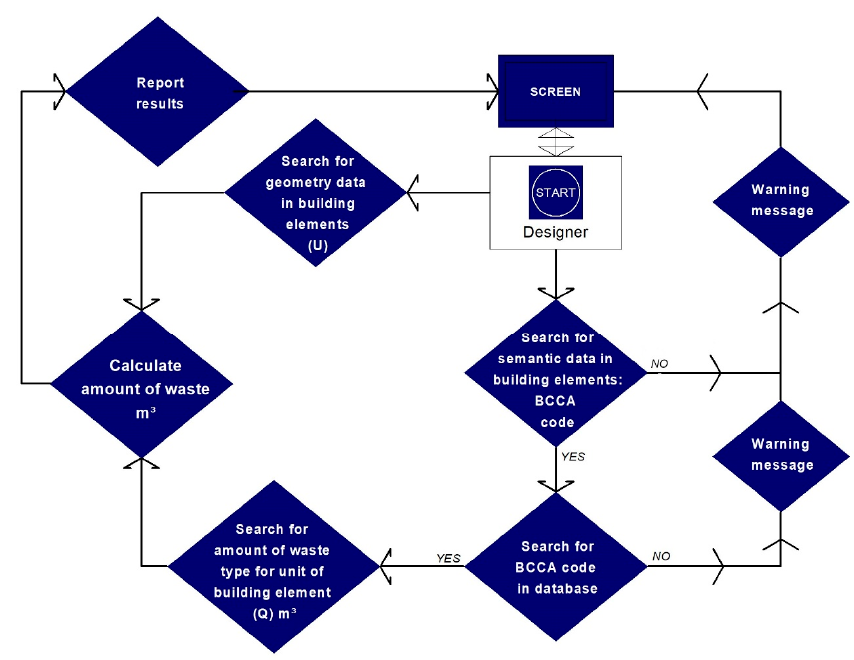
Figure 2. WE-BIM Add-in diagram of operation and